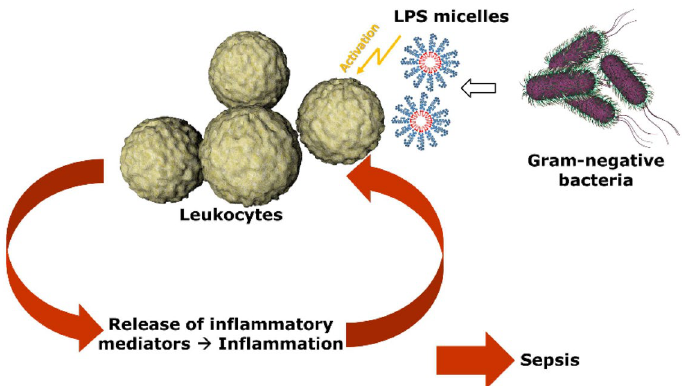
Figure 1. LPS stimulate the innate immunity. LPS in the blood activate monocytes, which leads to the secretion of inflammatory mediators. In systemic inflammation, this can lead to multiorgan failure and sepsis.